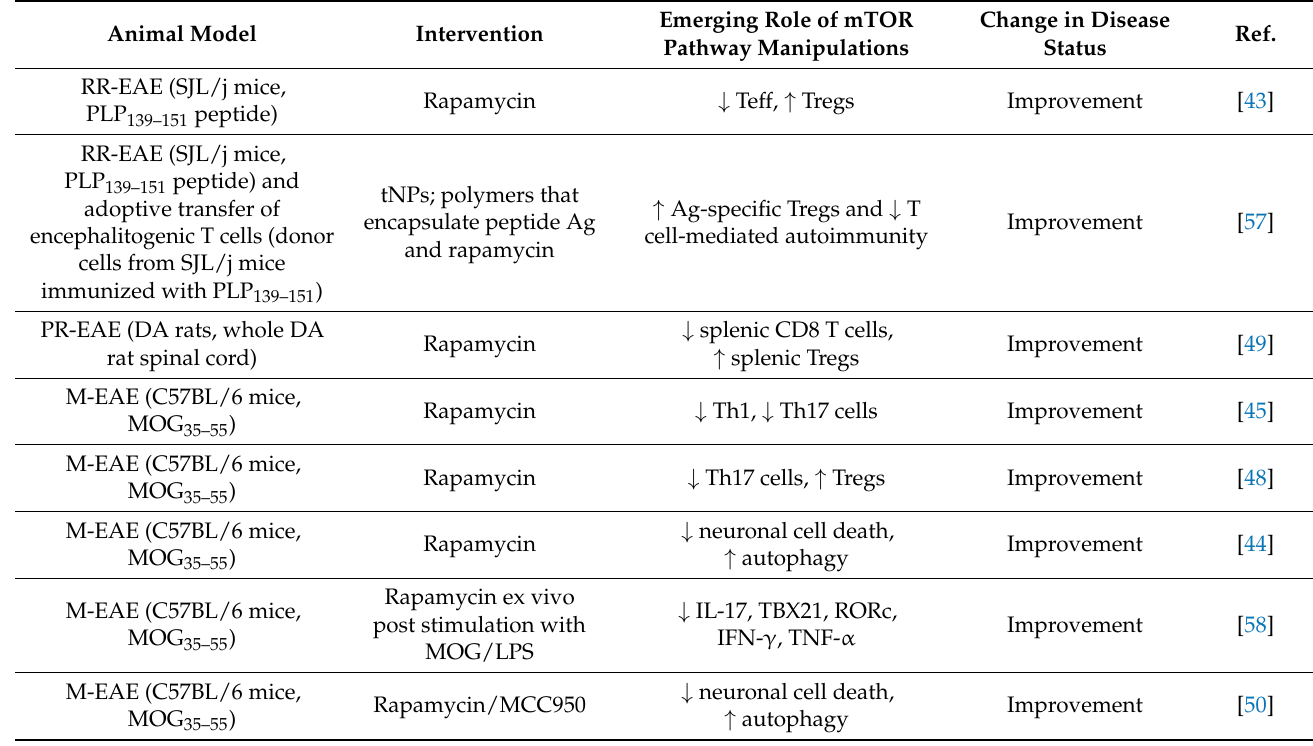
Table 2. mTOR inhibitors or knockout in animal of multiple